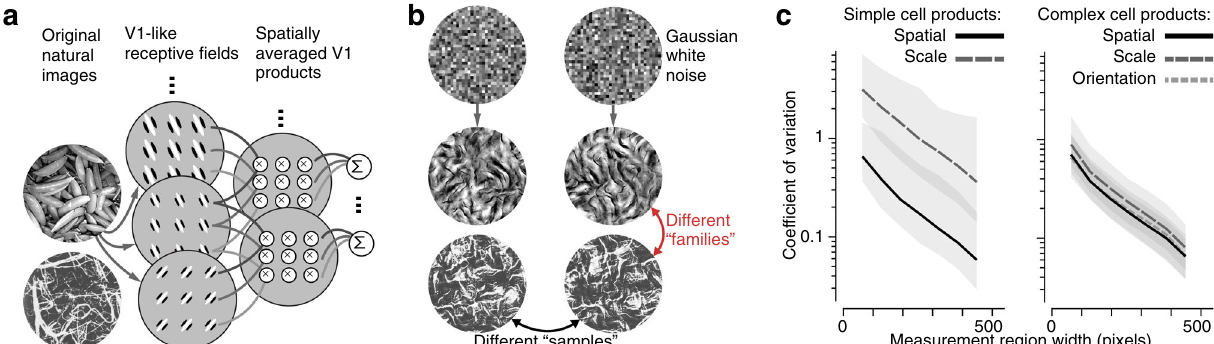
Fig. 1 Generation of synthetic texture stimuli. a Original photographs ( fi rst column) are decomposed into V1-like responses (recti fi ed oriented linear fi lter outputs) differing in orientation and spatial frequency (second column). Response statistics are computed by spatially averaging the products of responses at different orientations, spatial frequencies, and local positions (third column) 23 . b Images of Gaussian white noise (top) are iteratively adjusted until their statistics match those of the original images. Initializing with different random seeds yields different samples with identical statistics but differing in detail (columns), and different statistics yield samples from different texture families (rows). c Statistics converge with increasing measurement region width. Median coef fi cient of variation (standard deviation across samples divided by mean across samples) of example groups of higher-order statistics, as a function of the width of the region over which the statistics are measured. Products of simple cell responses (linear responses; left) and complex cell responses (magnitude responses; right) were measured from regions cropped from images synthesized to be statistically matched across their full extent (512 × 512 pixels). Shaded regions indicate interquartile range across different individual statistics computed from 15 texture families. Source data are provided as a Source Data fi